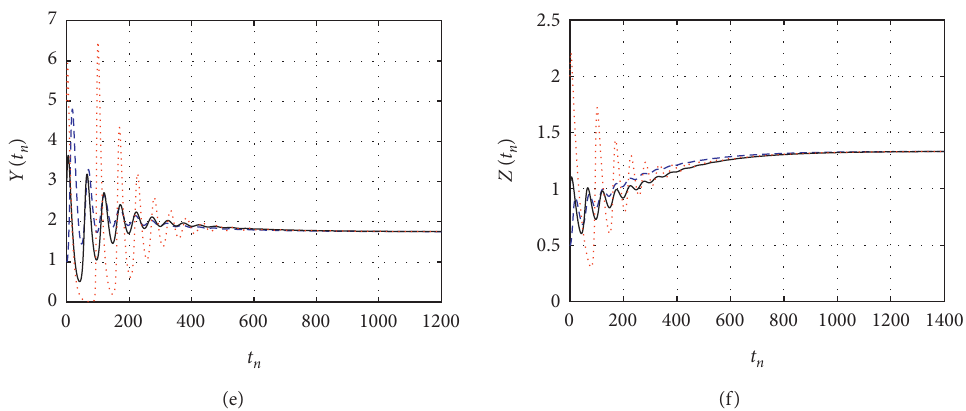
Figure 5: The solutions of systems (12)–(17) for case R Y